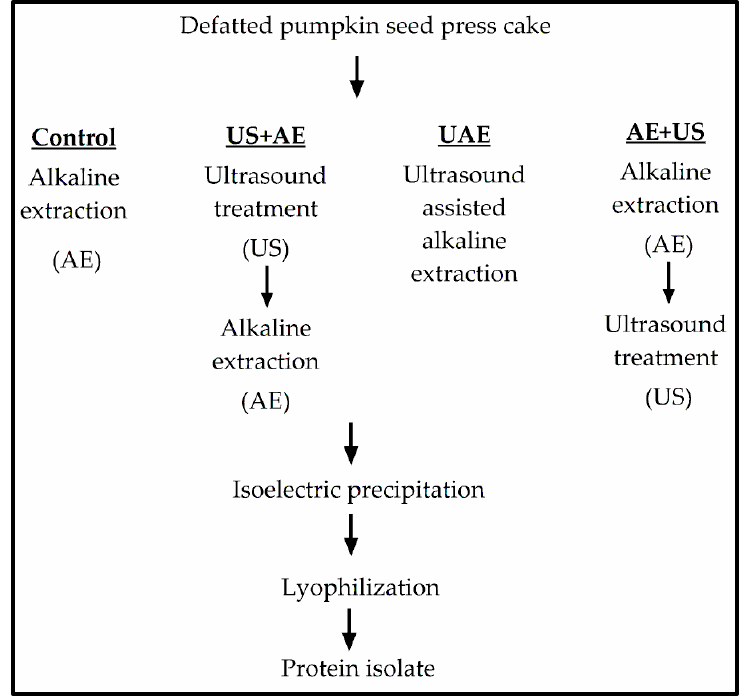
Figure 1. Outline of the protein isolation processes.